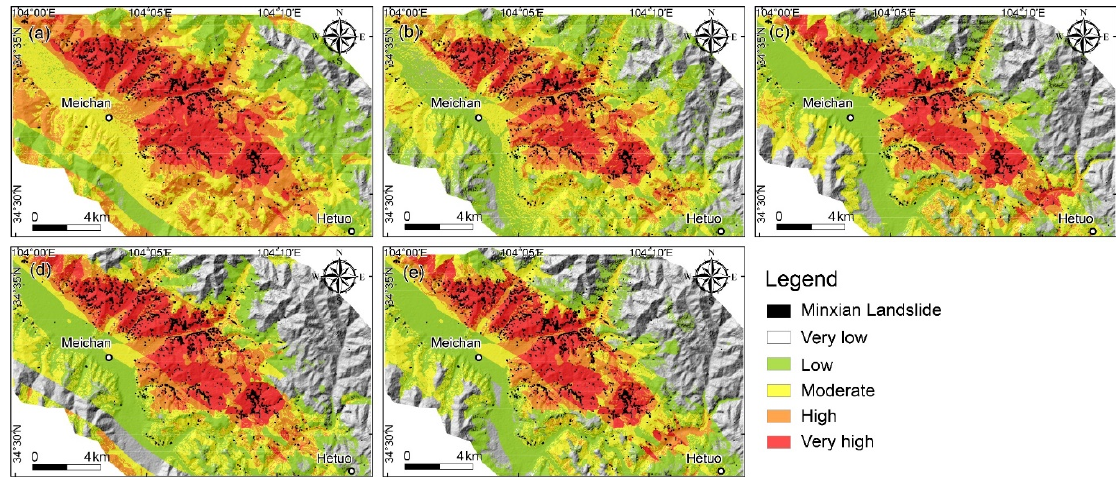
Figure 9. Distribution map of earthquake landslide susceptibility in Minxian area. ( a ) Information model; ( b ) CF model; ( c ) LR model; ( d ) I + LR model; ( e ) CF + LR model.